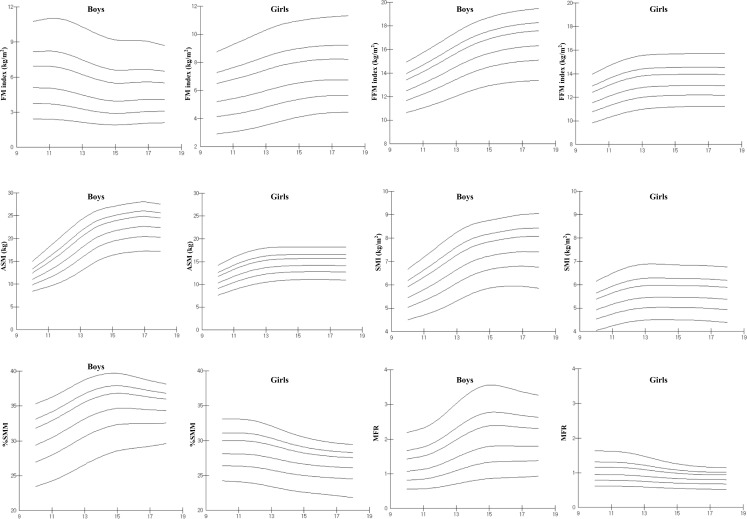
Percentile curves of skeletal muscle mass.Curves of the 5th, 25th, 50th, 75th, 85th, and 95th percentiles for fat mass index (FM index), fat-free mass index (FFM index), appendicular skeletal muscle mass (ASM), skeletal muscle index (SMI), %SMM, and skeletal muscle to body fat ratio (MFR) by sex and age.